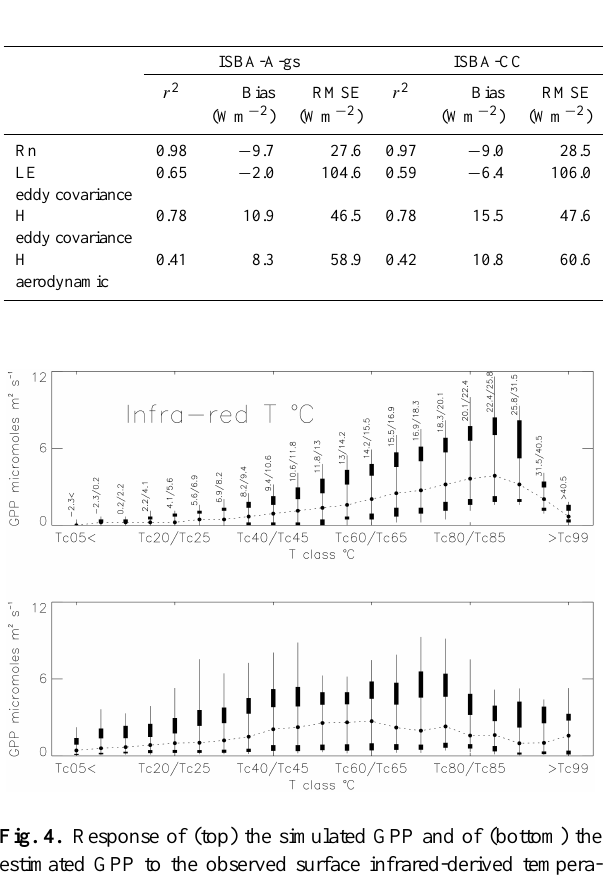
Table 4. ISBA-A-gs and ISBA-CC scores for water and en- ergy fluxes: Net Radiation (Rn), Latent Heat (LE) and sensible Heat (H). For H, eddy covariance and aerodynamic measurements are available. The observations are filtered for wind direction, u ∗ > 0.16ms − 1 , and the absence of water deposition.